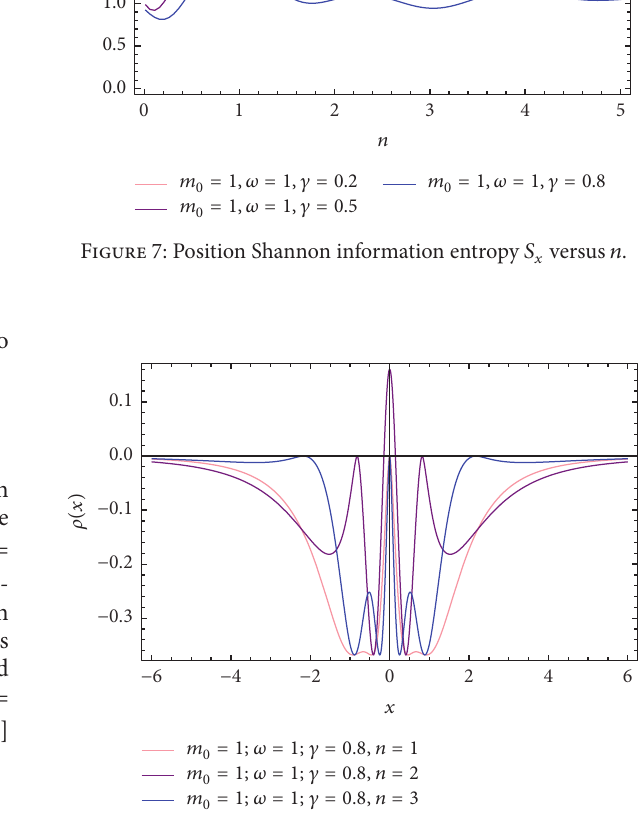
Figure 8: Position Shannon information entropy densities 𝜌(𝑥) versus 𝑥 .